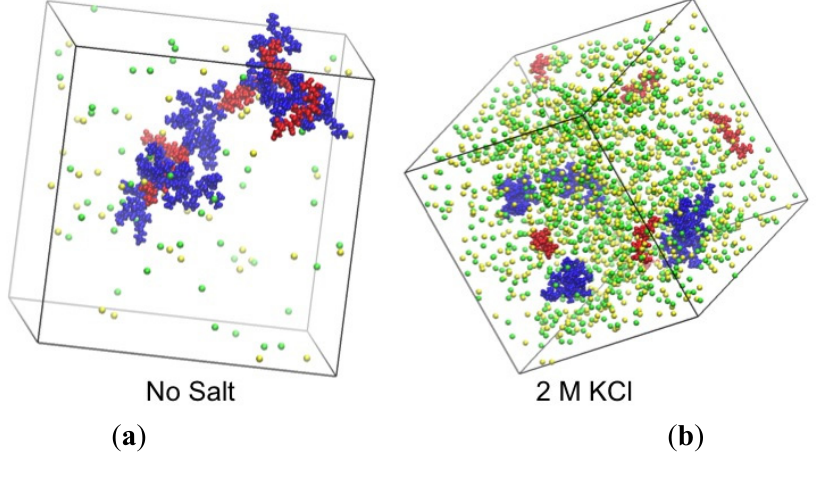
Figure 9. Snapshots from atomistic molecular dynamics simulations of ( a ) aqueous PAA (red)-PDMAEMA (blue)-K + (yellow)-Cl − (green) mixture without salt and ( b ) with 2 M KCl. Water molecules are not shown. Fully ionized PAA and PDMAEMA chains (five chains each with 10-monomers per chain) are simulated in a cubic simulation box with length ≈ 9 nm, corresponding to a monomer concentration of ≈ 0.11 M for both PAA and